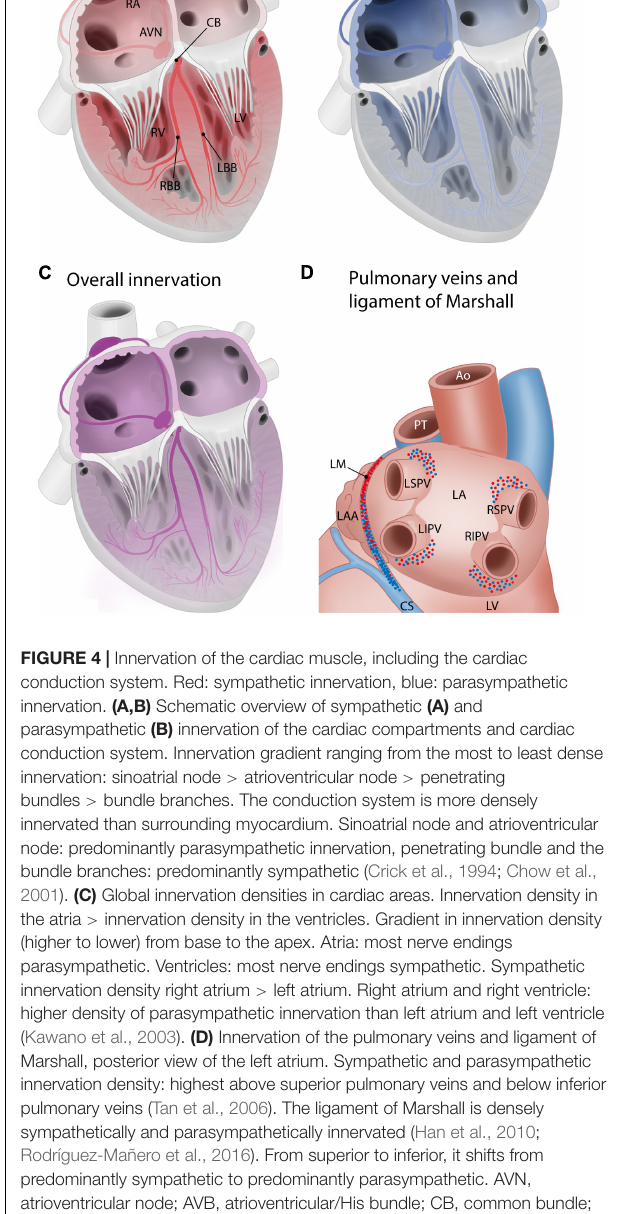
TABLE 3 | Summary of asymmetrical and regional features of the extrinsic cardiac plexus, coronary cardiac nerves, and intrinsic cardiac plexus (all human studies). • Right-sided extrinsic cardiac plexus formation located more superiorly (level of brachiocephalic trunk) than left-sided extrinsic cardiac plexus (level of aortic arch) {Kawashima, 2011 #222}